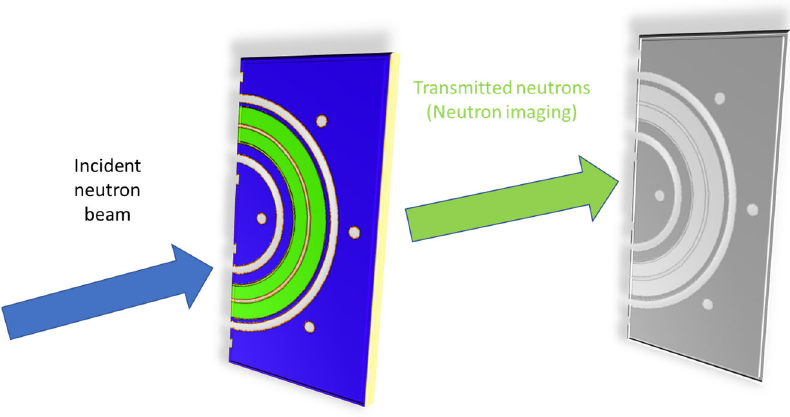
Figure 3. The attenuation contrast image of an object irradiated with a neutron Figure 3. The a tt enuation contrast image of an object irradiated with a neutron beam.